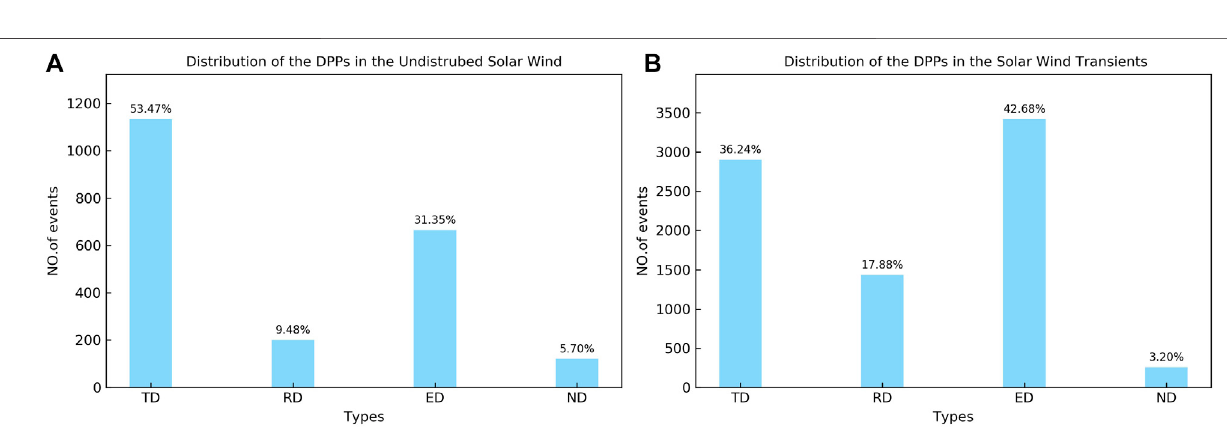
Frontiers in Physics |